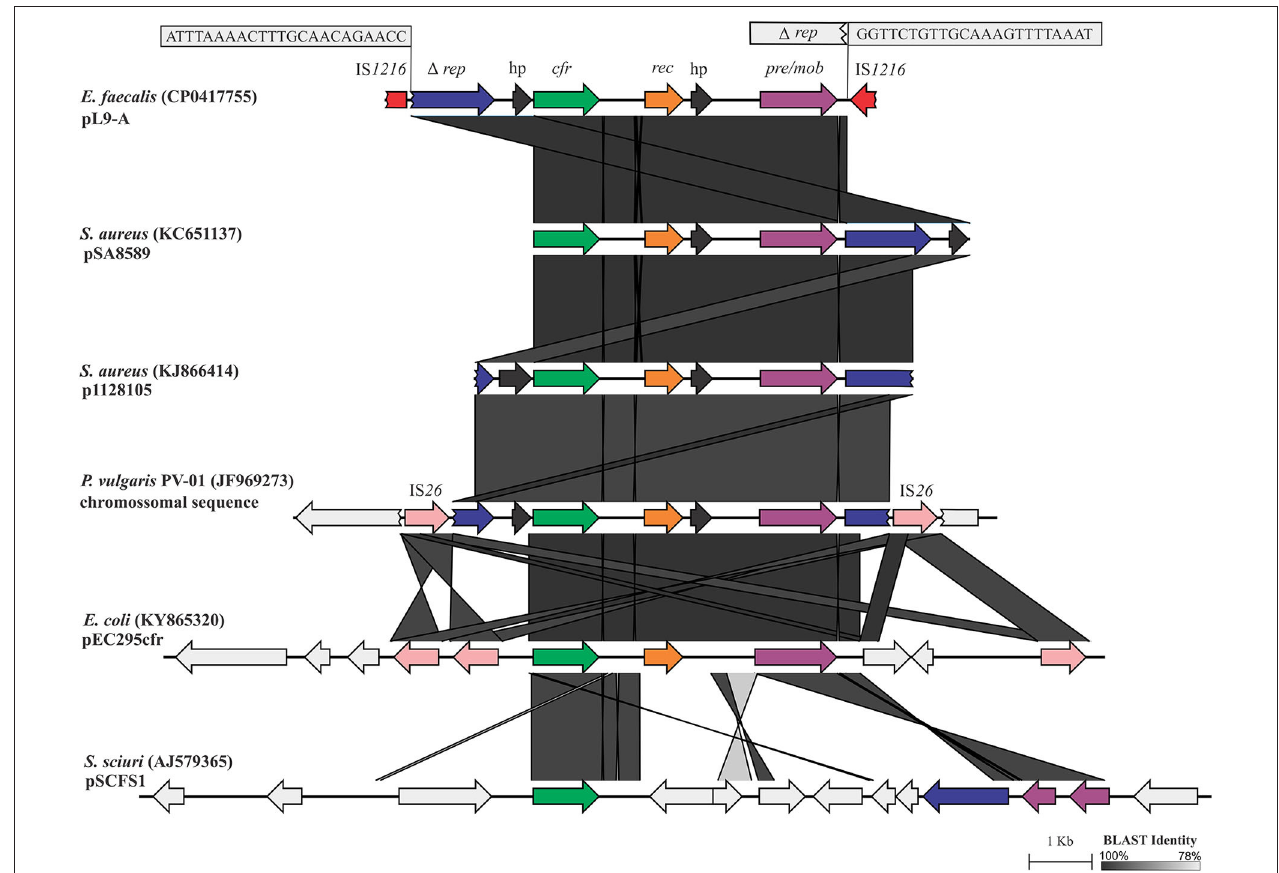
FIGURE 1 | Linear comparison of the 7,759-bp cfr -carrying DNA segment pL9-A (CP041775.1) generated by EasyFig. The boxes zoom in on the 23-bp inverted repeats (IR) at the ends of an IS 1216 that was inserted into repUS18 . The 6,956-bp segment between the IRs shows high DNA identity to the corresponding stretches in pSA8589 (KC651137), p1128105 (KJ866414), and P. vulgaris PV-01 chromosomal sequence (JF969273). Alignment of these sequences revealed only a deletion of 7 bp in repUS18 from pL9-A and an insertion of 10 bp in the hypothetical protein on the flank 5 ′ of cfr in p1128105, which is represented by the slightly lighter shade of identity over this region.